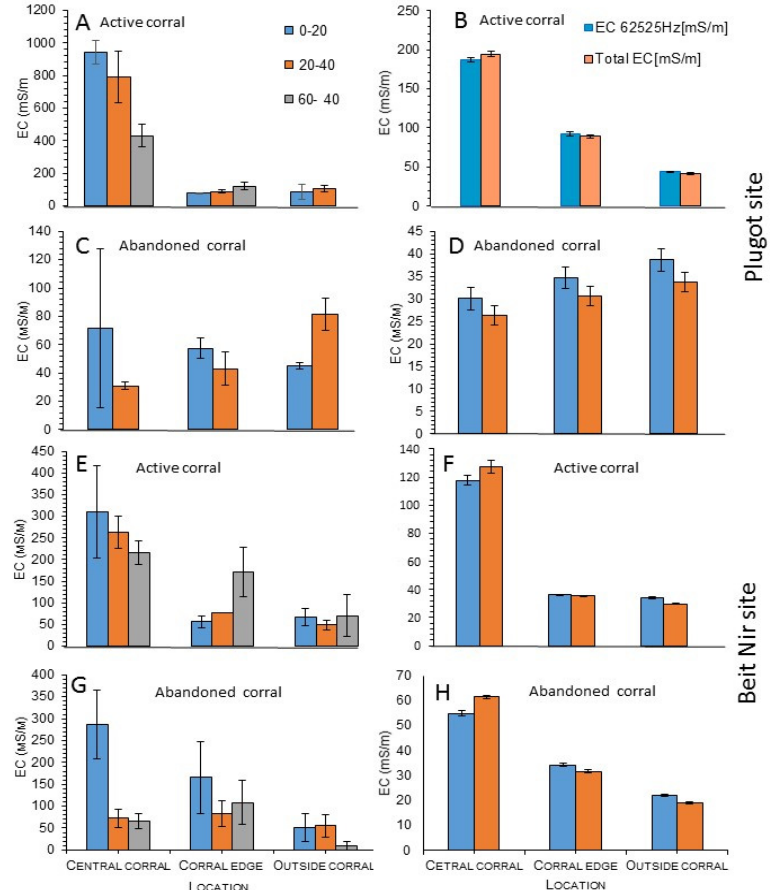
Figure 7. Comparison between EC values measured in the laboratory; A —in an active and C —abandoned corral at the Plugot forest site by depth (cm); E —in an active and G —abandoned corral at the Beit Nir site by depth (cm). EC measurements obtained with the FDEM; B —in an active and D — abandoned corral at the Plugot forest site; F —in an active and H —abandoned corral at the Beit Nir site. The EC is 62,525 Hz (mS/m) on average the total various frequencies (mean ±SD).